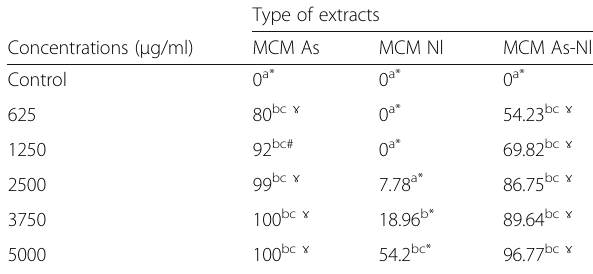
Table 1 Effect of Methylene Chloride-Methanol of Annona Table 3 Effect of Methylene Chloride-Methanol of Annona senegalensis , Nauclea latifolia and their mixture on fresh egg senegalensis, Nauclea latifolia and their mixture on L 1 (%) according to concentrations after 48 h of exposure Type of extracts Concentrations ( μ g/ml)